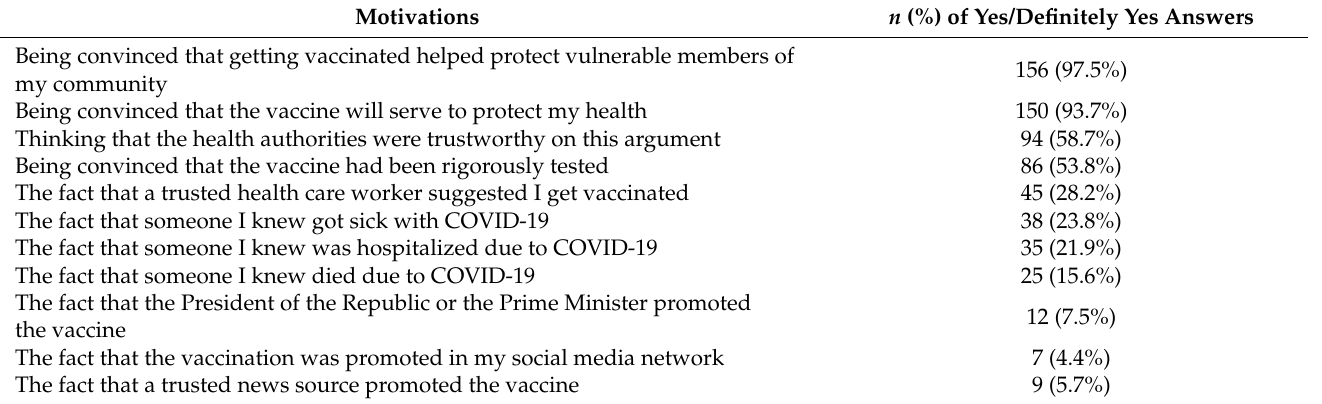
Table 1. Ranking of the motivations behind getting the COVID-19 vaccine (total analyzed n = 160).